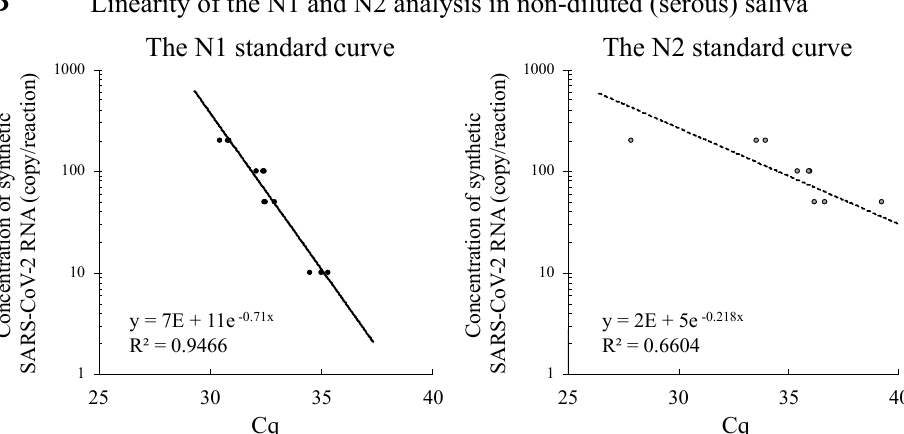
Figure 2. Linearity of the N1 and N2 amplifications in RNase-free water (RFW) and non-diluted saliva. Human saliva samples were collected from healthy volunteers. ( A ) N1 and N2 standard curves in RFW. ( B ) N1 and N2 standard curves in non-diluted saliva. Y axis indicates concentration of SARS-CoV-2 RNA STDs (1000, 800, 600, 400, 200, 100, and 50 to 10 cp/reaction; non-diluted saliva: 200, 100, and 50 to 10 cp/reaction), and X axis indicates the quantification cycles performed by LightCycler ® 96 software.